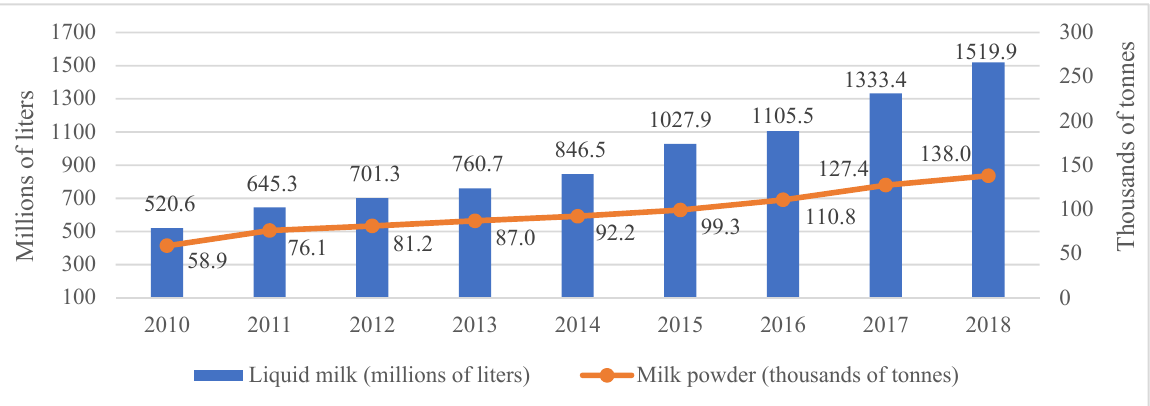
Figure 3. The quantity of fresh milk and milk powder. Source: Authors’ analysis based on GSO [36].